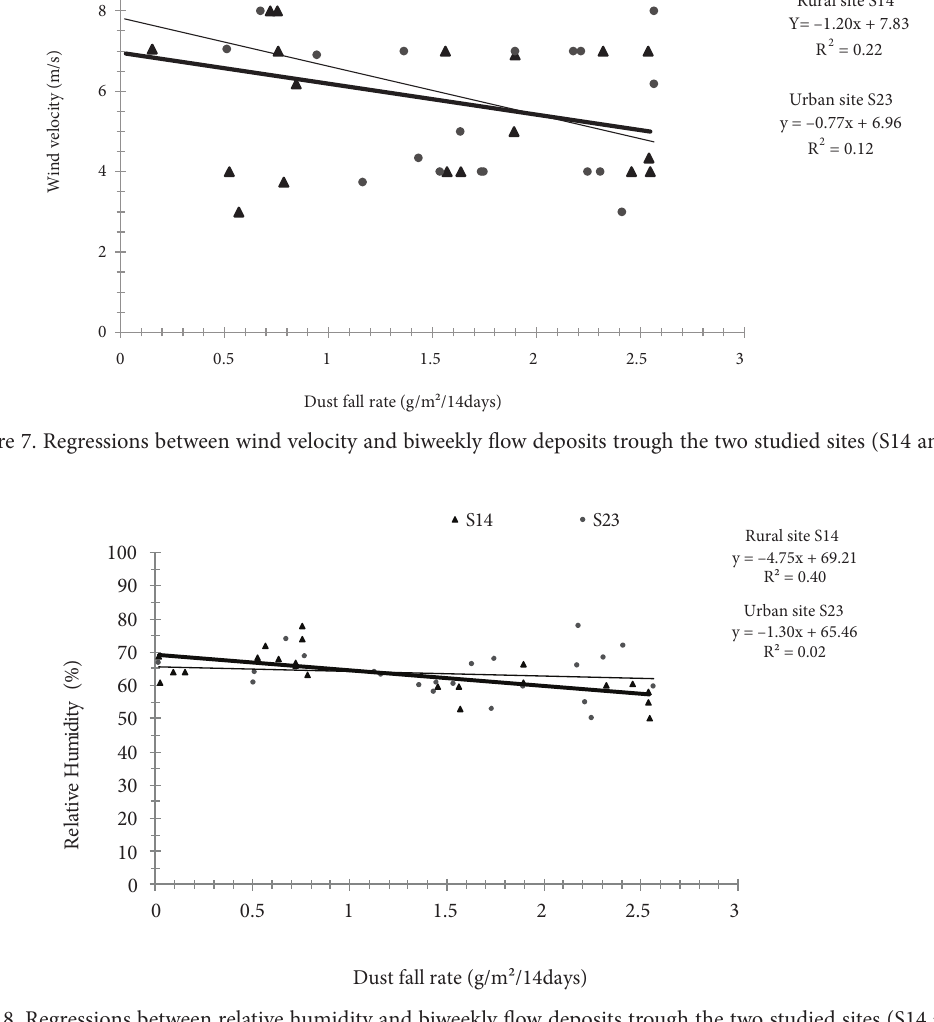
Figure 8. Regressions between relative humidity and biweekly flow deposits trough the two studied sites (S14 and S23)